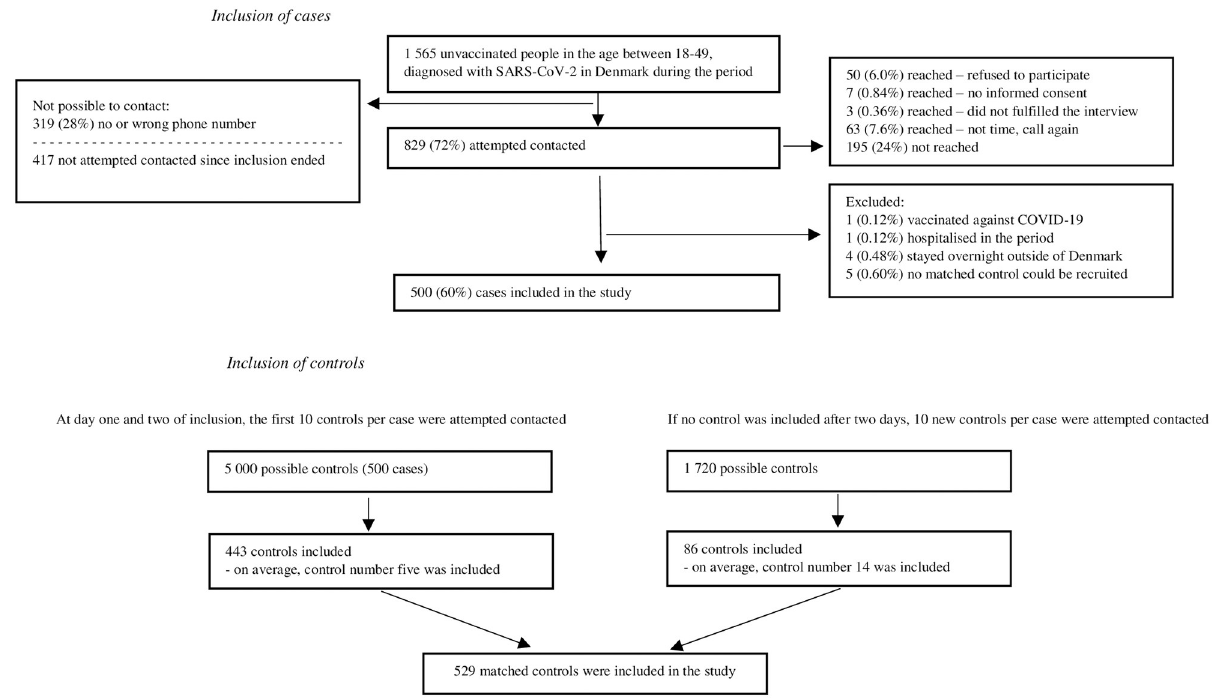
Fig 2. Flow diagram illustrating inclusion of cases and